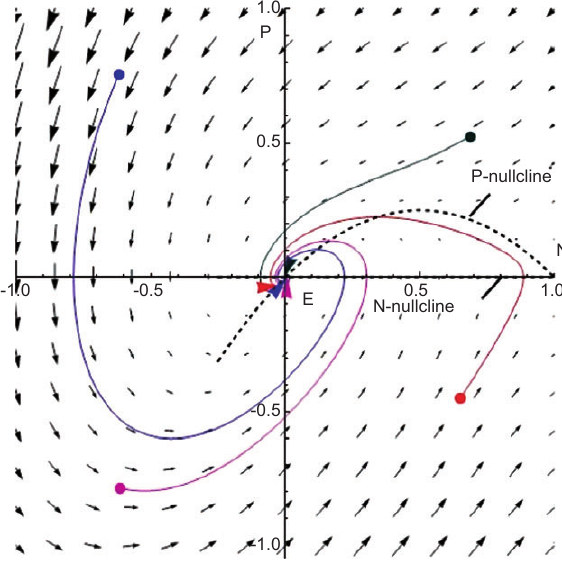
Figure 5 Phase plane dynamics of system (41) of ODEs with parameter values r = v = =